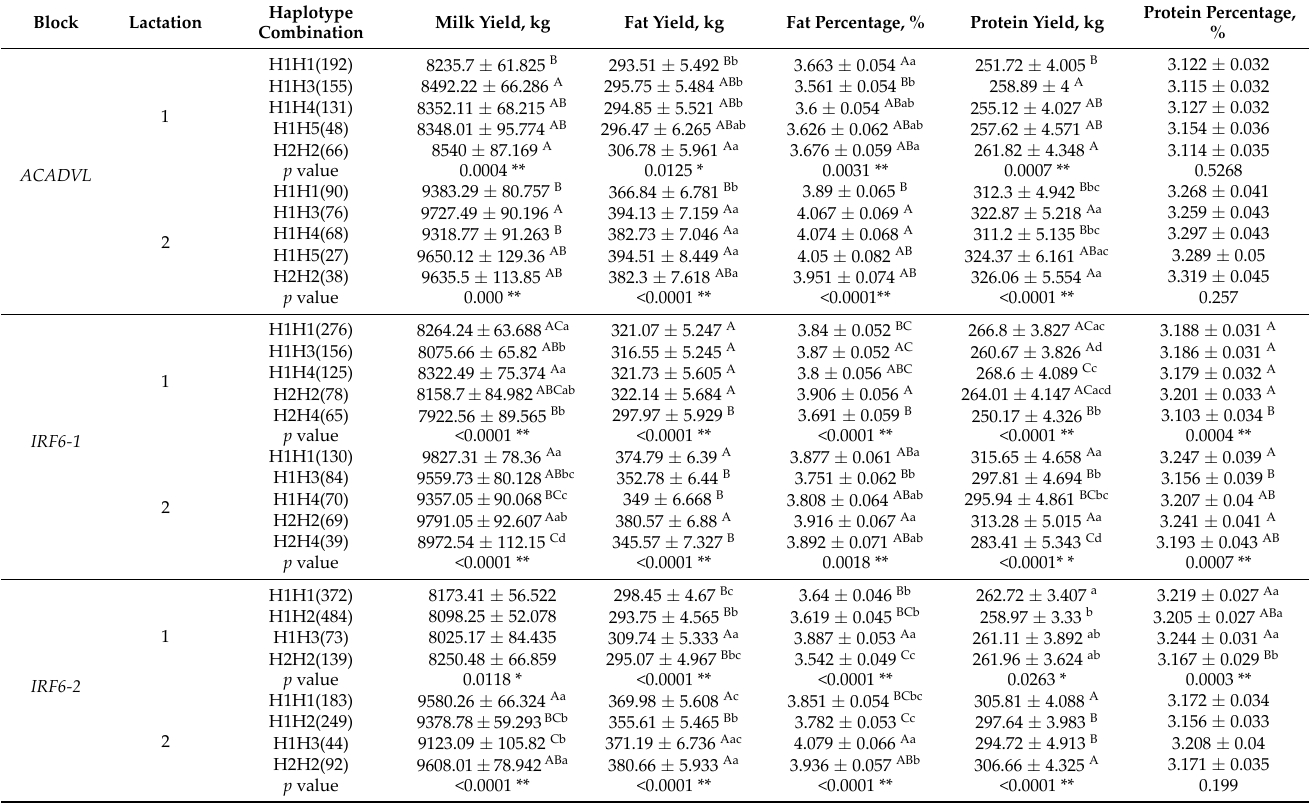
Table 3. Associations of the haplotype blocks with milk production traits in two lactations in Holstein cattle (LSM ± SE).